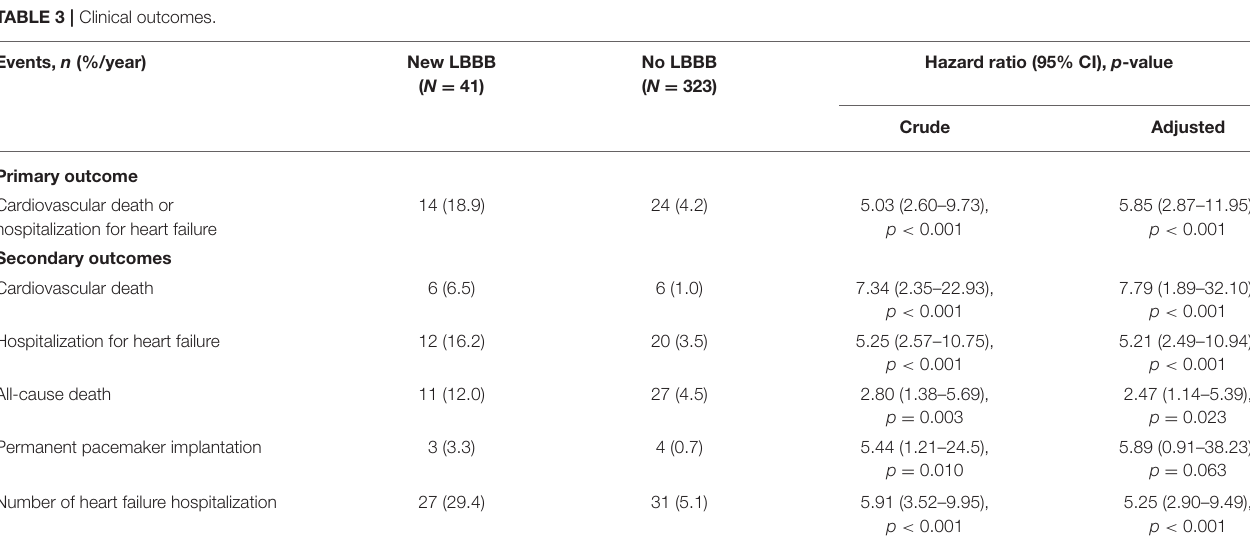
TABLE 3 | Clinical